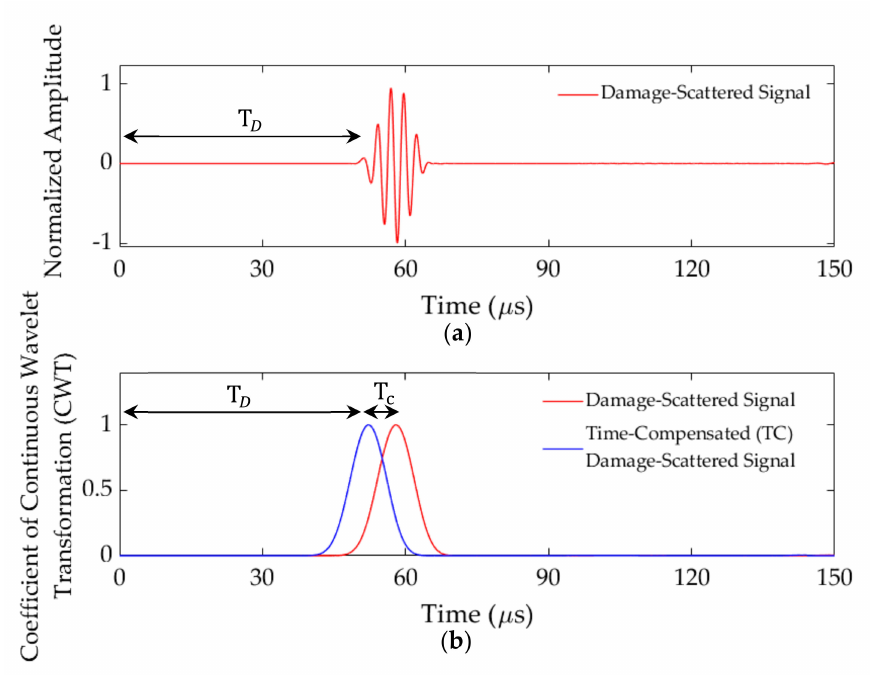
Figure 2. ( a ) A damage-scattered signal; ( b ) coe ffi cient of continuous wavelet transformation (CWT) with and without time compensation.